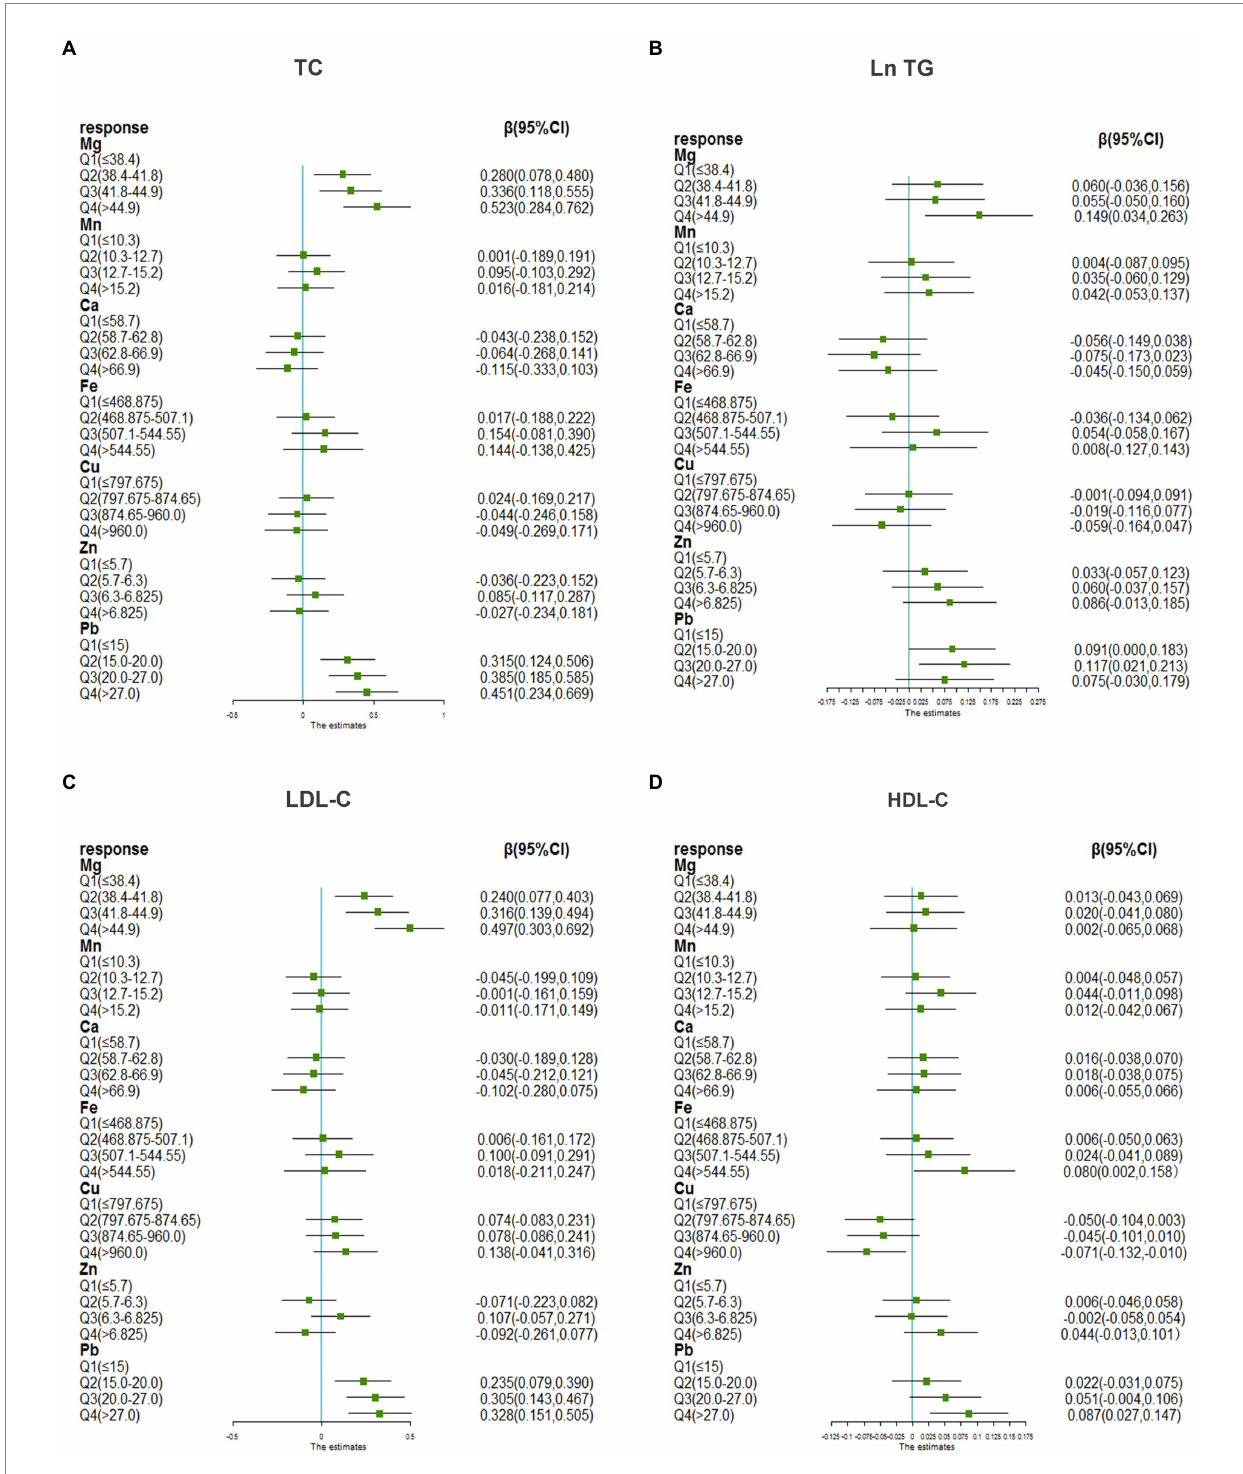
using a variety of statistical approaches. The linear regression pointed out that higher blood Pb levels were associated with higher serum TC,